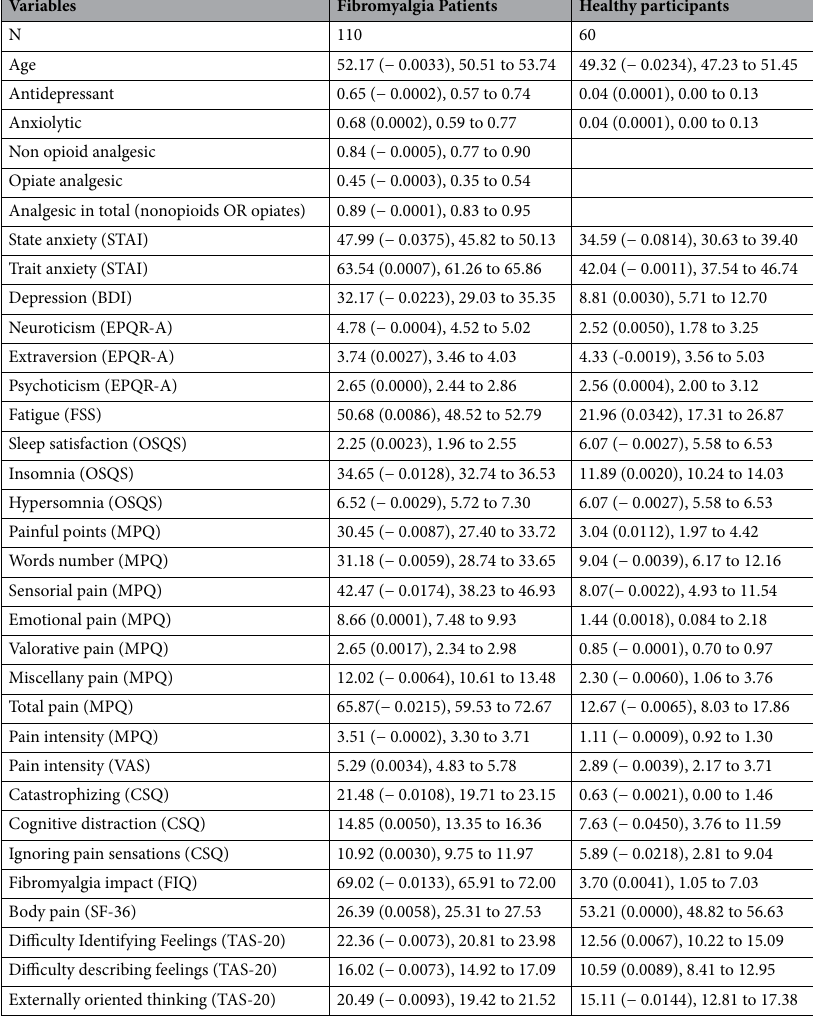
Table 1. Descriptive statistics with means (bootstrap biases) and bootstrap 95% CIs of demographics, psychological, and clinical data of Fibromyalgia patients and Healthy